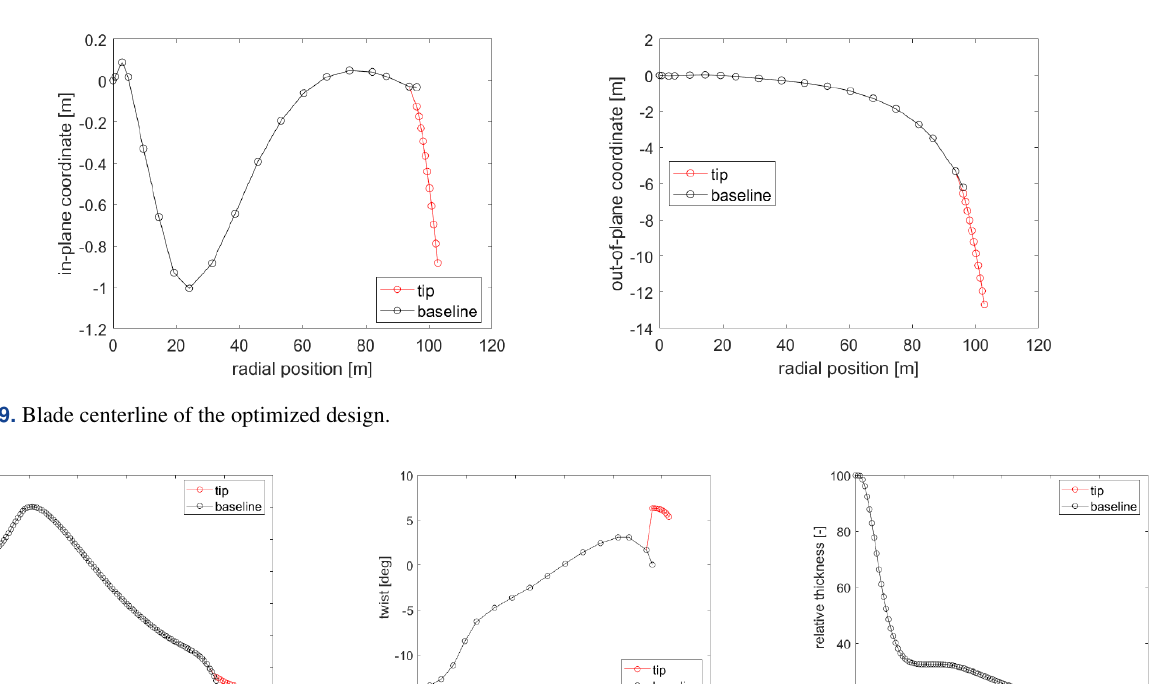
Figure 8. Blade 3D surface comparison between baseline geometry (in black) and optimized tip extension (in red). (a) In-plane view and (b) out-of-plane view. For reference, a background grid with a spacing of 3.5m is included.